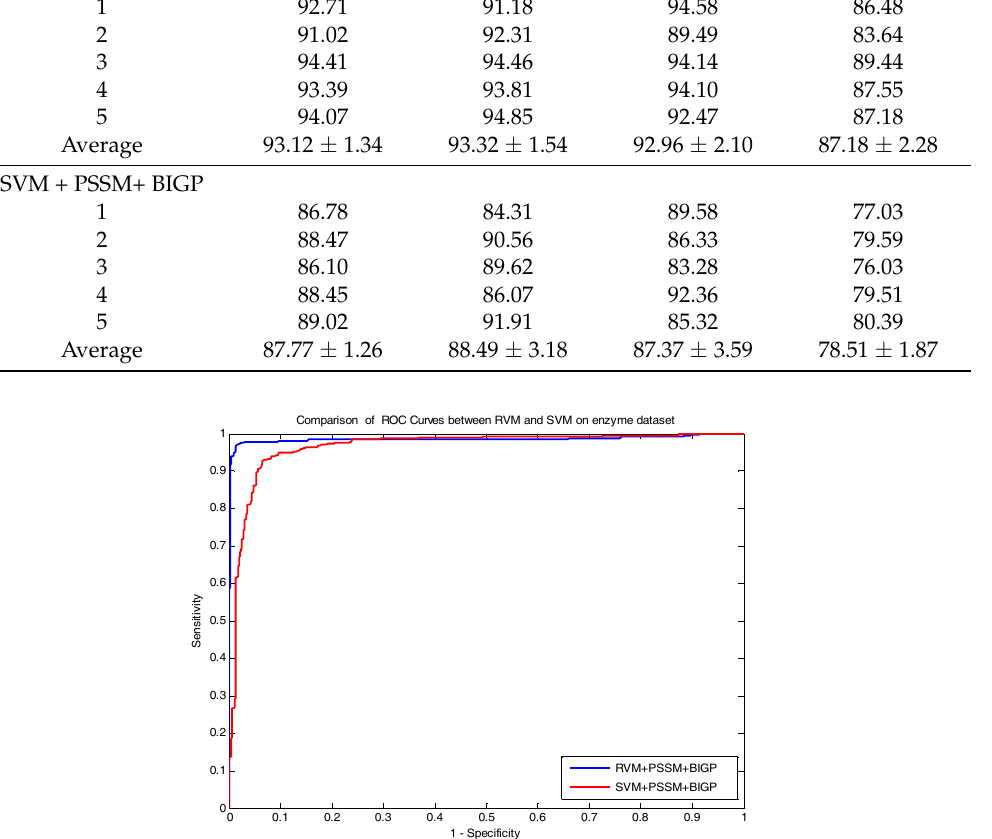
Molecules 2017 , 22 , 1119